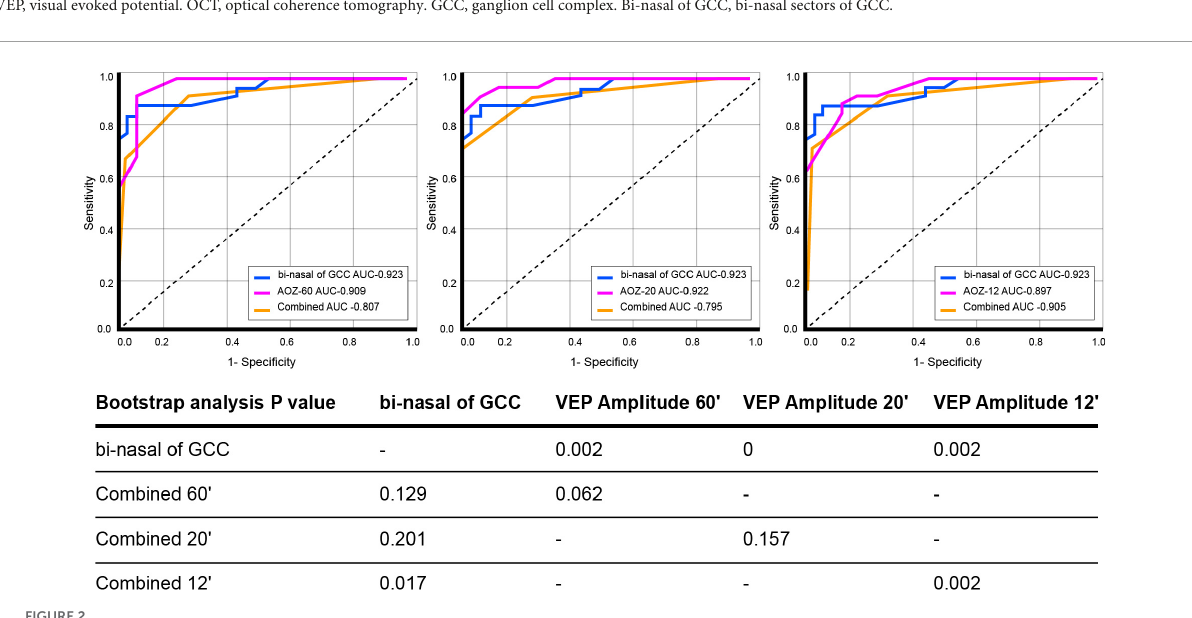
< 0.01) does too. RNFL showed a 0 − 12 months